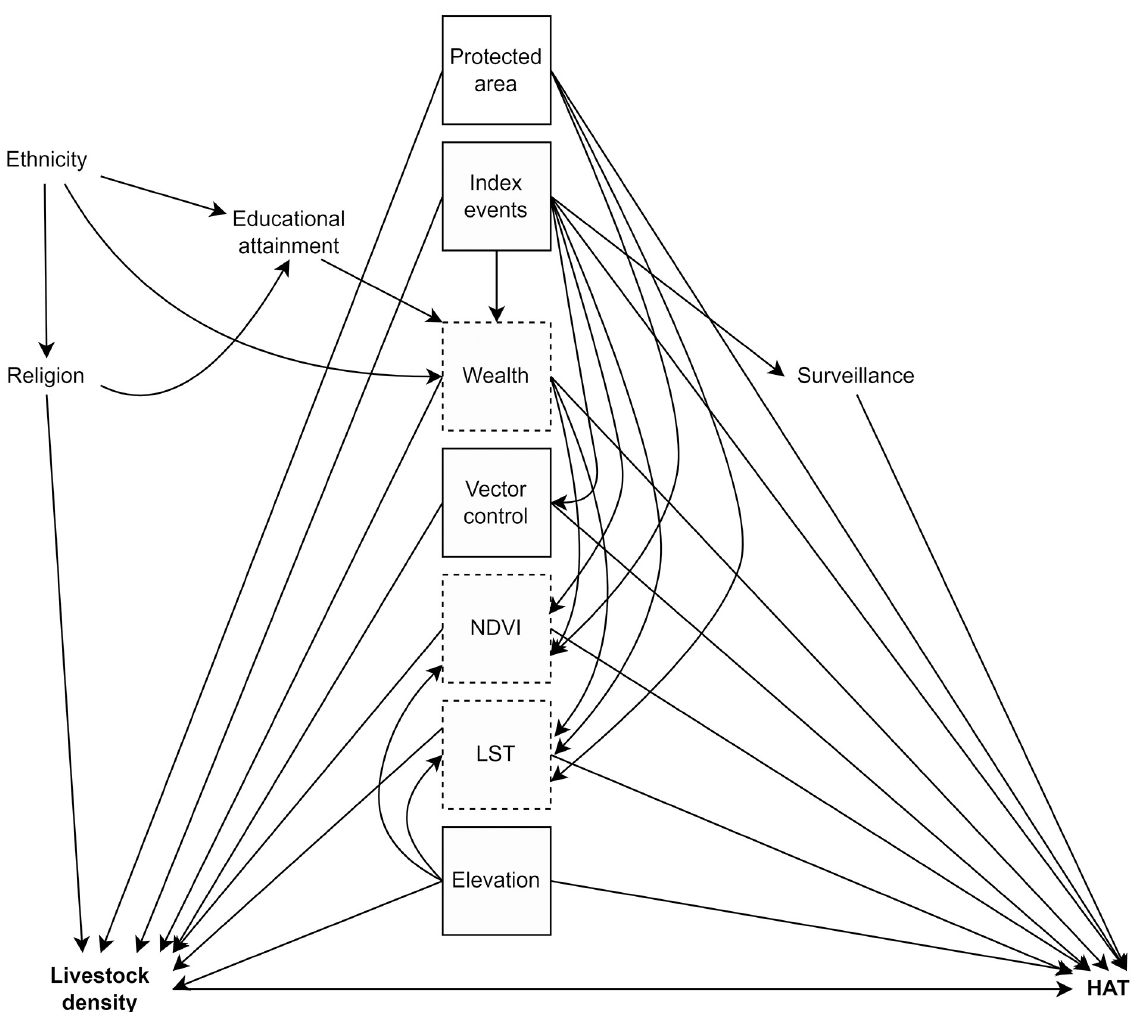
Fig 1. Time-stratified directed acyclic graph (DAG). Boxed variables are those in the minimum sufficient adjustment set; those with a dashed line exhibit exposure-confounder feedback. Bolded variables are the exposure and outcome of interest. Protected areas refers to rHAT models